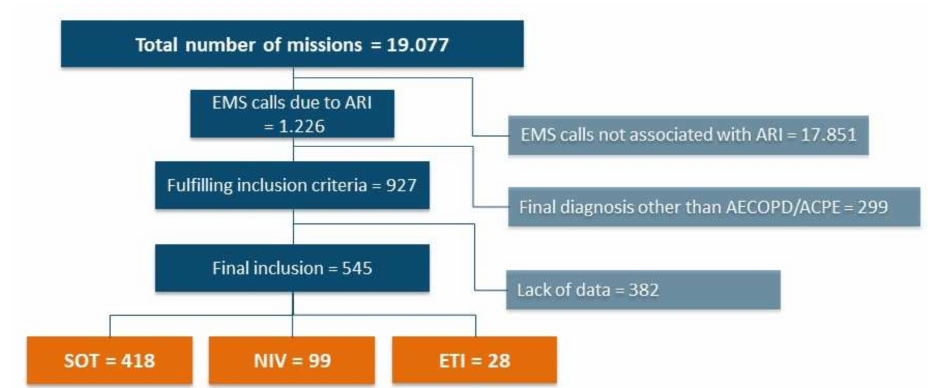
Figure 1. Data collection and inclusion. Flowchart of data collection process, data exclusion and allocation of patients to respective study groups, shown as number of patients. Abbreviations: EMS = emergency medical service, ARI = acute respiratory insufficiency, AECOPD = acute ex- acerbation of chronic obstructive pulmonary disease, ACPE = acute cardiopulmonary oedema, SOT = standard oxygen therapy, NIV = non-invasive ventilation, ETI = endotracheal intubation.